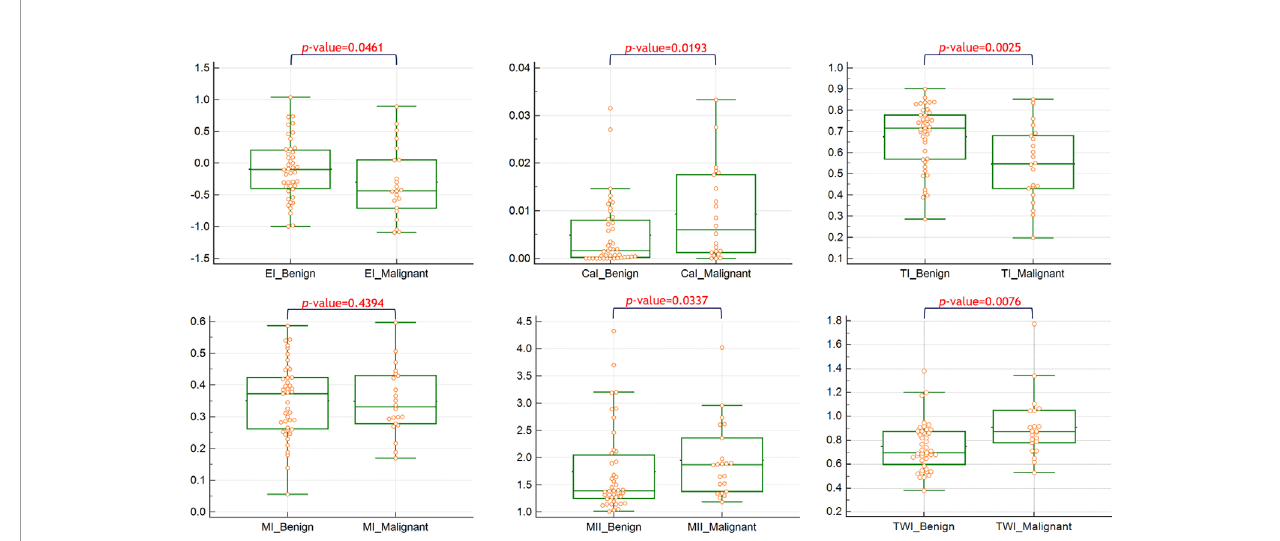
FIGURE 1 | The quantitative values of the features between benign and malignant nodules.